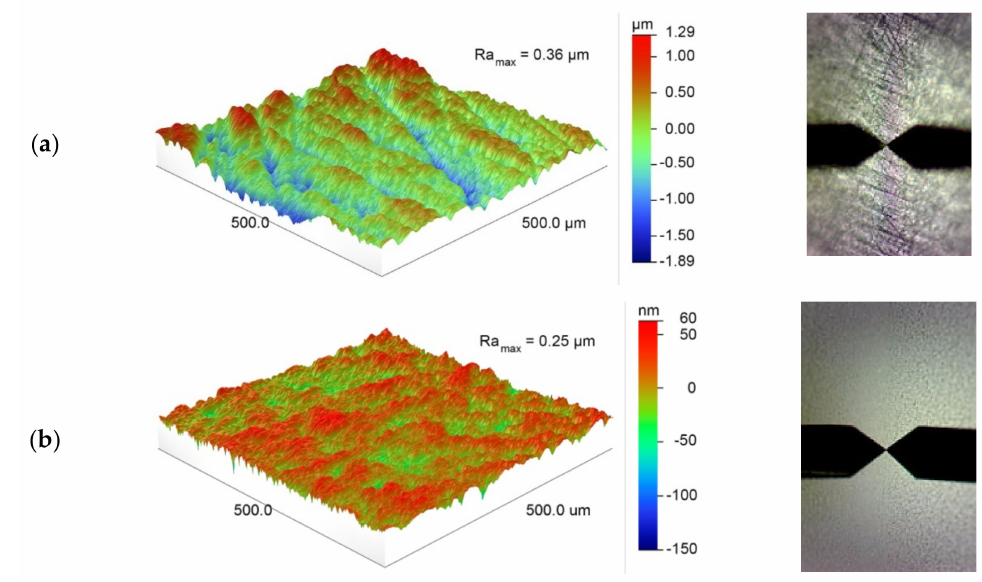
Figure 9. 3D profilograms of a cutting plate surface before ( a ) and after processing ( b ) as well as photographs of the plate surface and the stylus with its shadow on the surface (on the right).